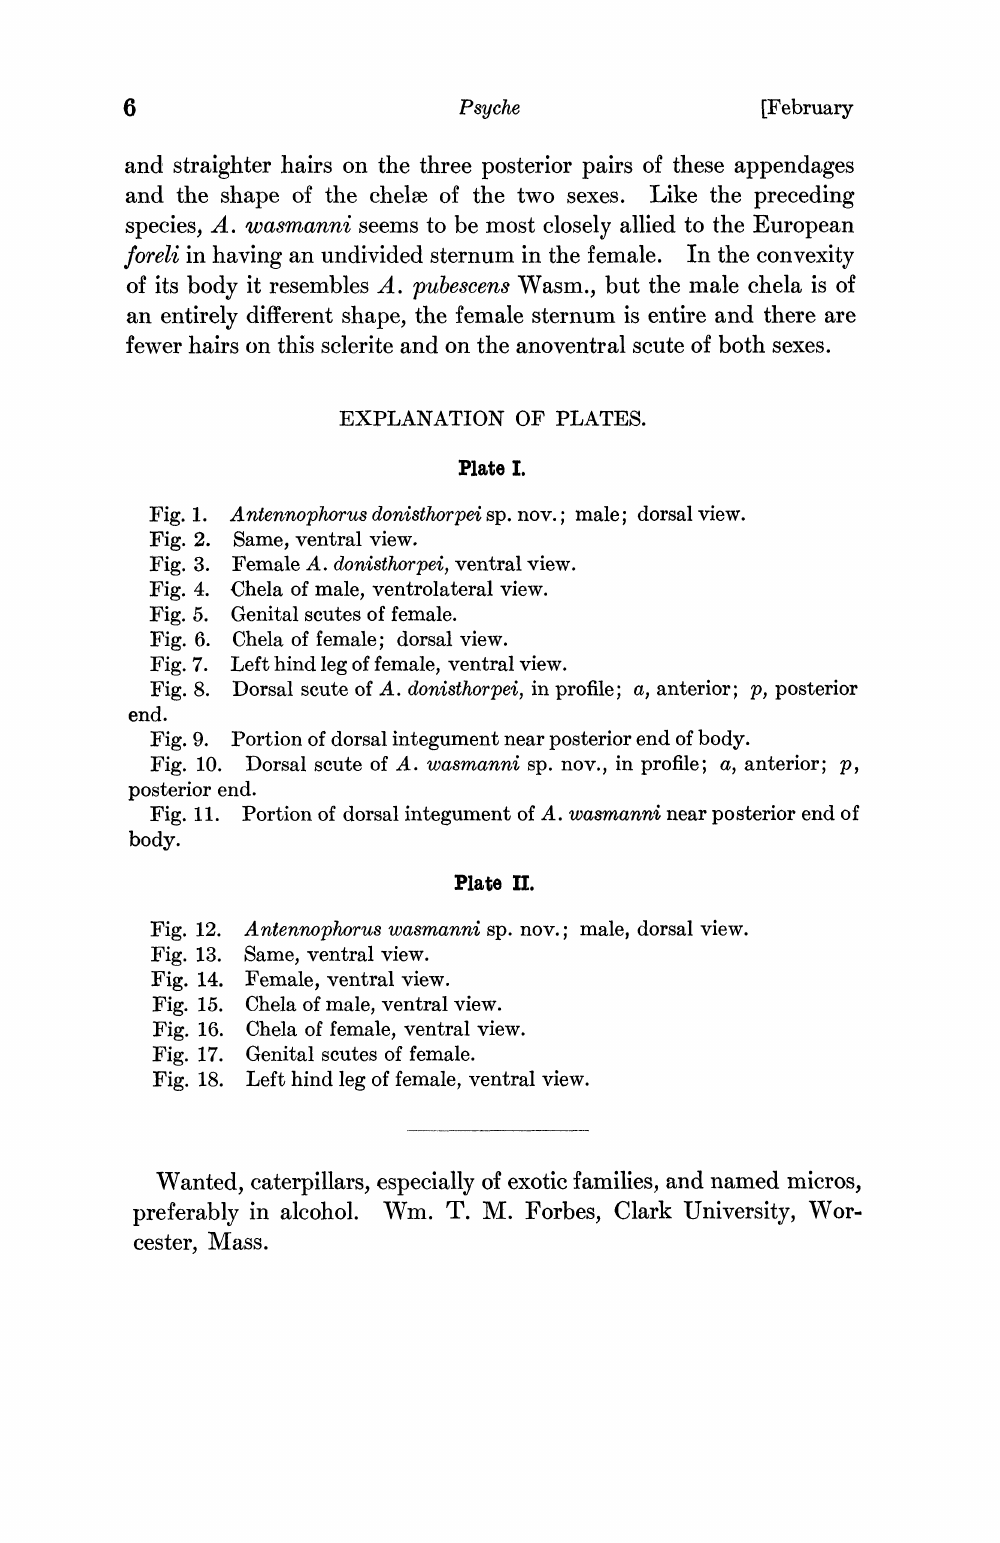
Fig. 1. Antennophorus donisthorpei sp. nov.; male; dorsal view. Fig. 2. Same, ventral view. Fig. 3. Female A. donisthorpei, ventral view. Fig. 4. Chela of male, ventrolateral view. Fig. 5. Genital scutes of female. Fig. 6. Chela of female; dorsal view. Fig. 7. Left hind leg of female, ventral view. Fig. 8. Dorsal scute of A. donisthorpei, in profile; a, anterior; p, posterior end. Fig. 9. Portion of dorsal integument near posterior end of body. Fig. 10. Dorsal scute of A. wasmanni sp. nov., in profile; a, anterior; p, posterior end. Fig. 11. Portion of dorsal integument of A. wasmanni near posterior end of body.